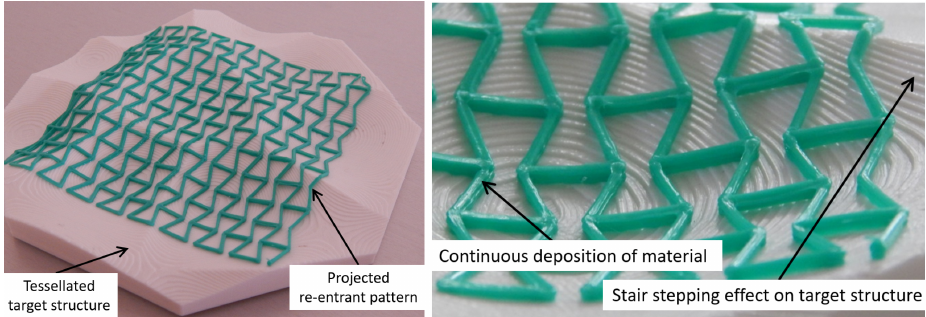
Figure 16. Actual 3D printing of the re-entrant pattern projected on an arbitrary tessellated